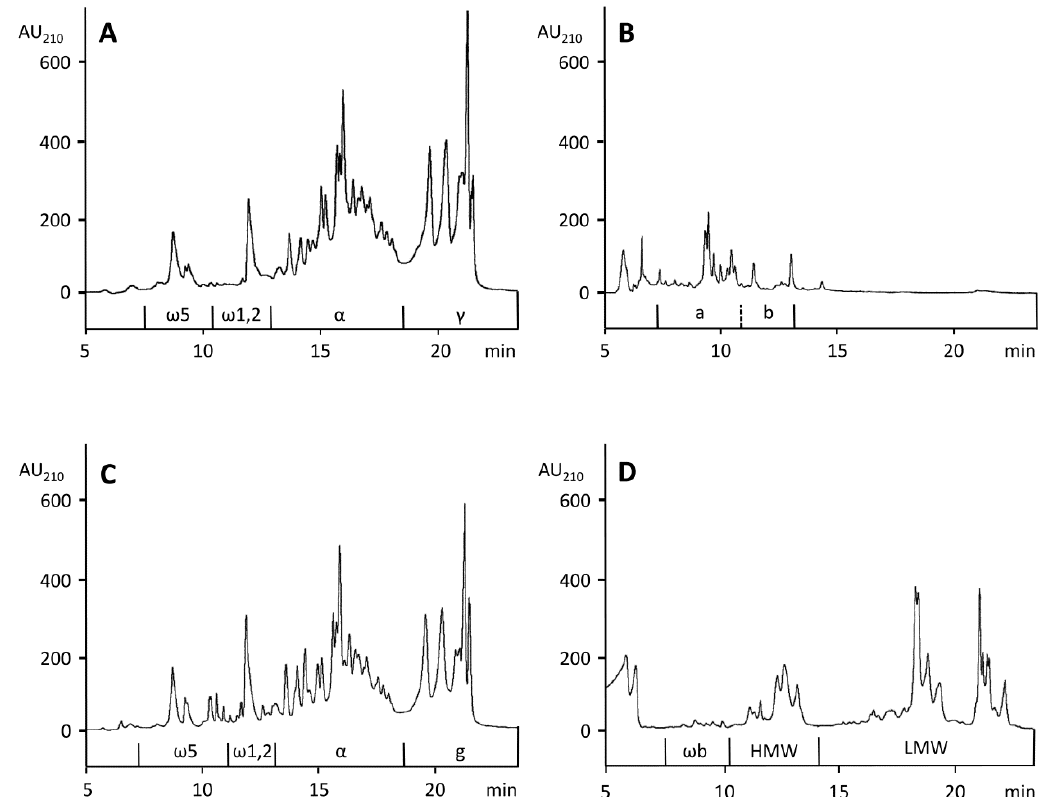
Figure 2. Reversed-phase high-performance liquid chromatography (RP-HPLC) for gluten proteins of prolamin working group (PWG)-gliadin ( A ), the ALGL fraction ( B ), the ALGL + gliadins (GLIA) fraction ( C ) and the glutenin subunits (GLUT) fraction ( D ). AU 210 , absorbance units at 210 nm, ALGL, albumins and globulins, HMW, high-molecular-weight glutenin subunits, LMW, low-molecular-weight glutenin subunits, α , α -gliadins, γ , γ -gliadins, ω 5, ω 5-gliadins, ω 1,2, ω 1,2-gliadins, ω b, ω b-gliadins.